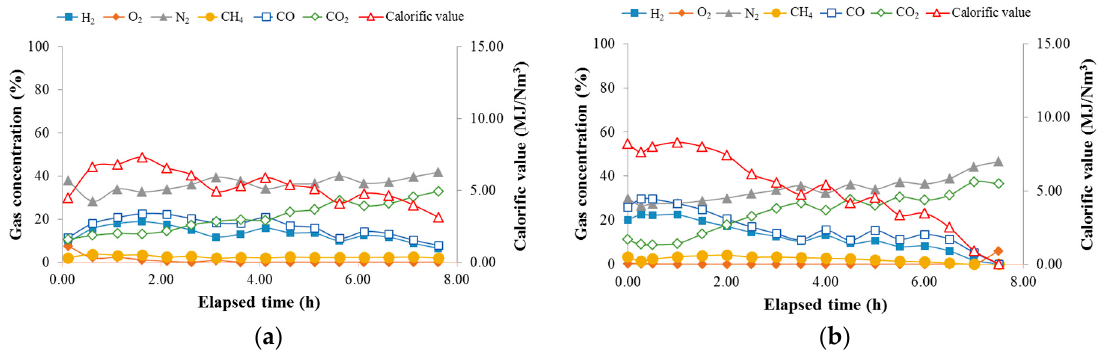
Figure 9. Main compositions and the calorific value of a product gas: ( a ) Experiment 1; ( b ) Experiment 2.